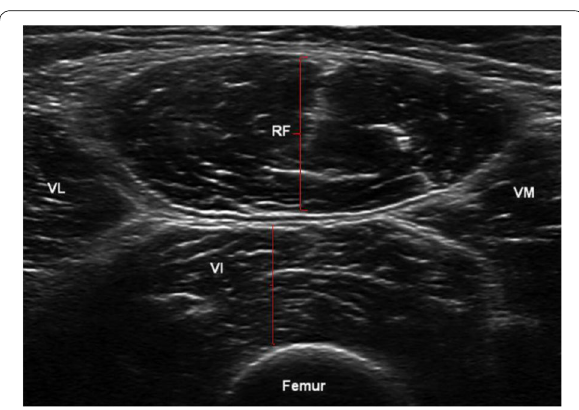
Fig. 3 The muscle layer thickness detected by ultrasound. Quadriceps femoris detected by ultrasound in a transverse scan. The rectus femoris (RF) layer thickness and vastus intermedius (VI) are represented (red lines). VM vastus medialis, VL vastus